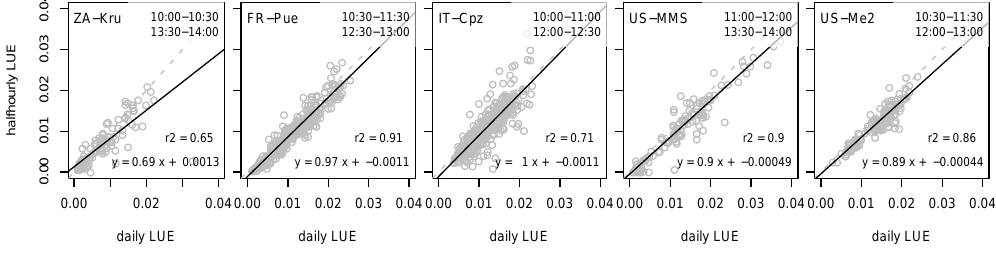
Fig. 1. Comparing daily and half-hourly light use efficiency (based on MODIS faPAR) for all the cloud free times where MODIS PRI is available. The times of MODIS overpass are given in the upper right corner of each